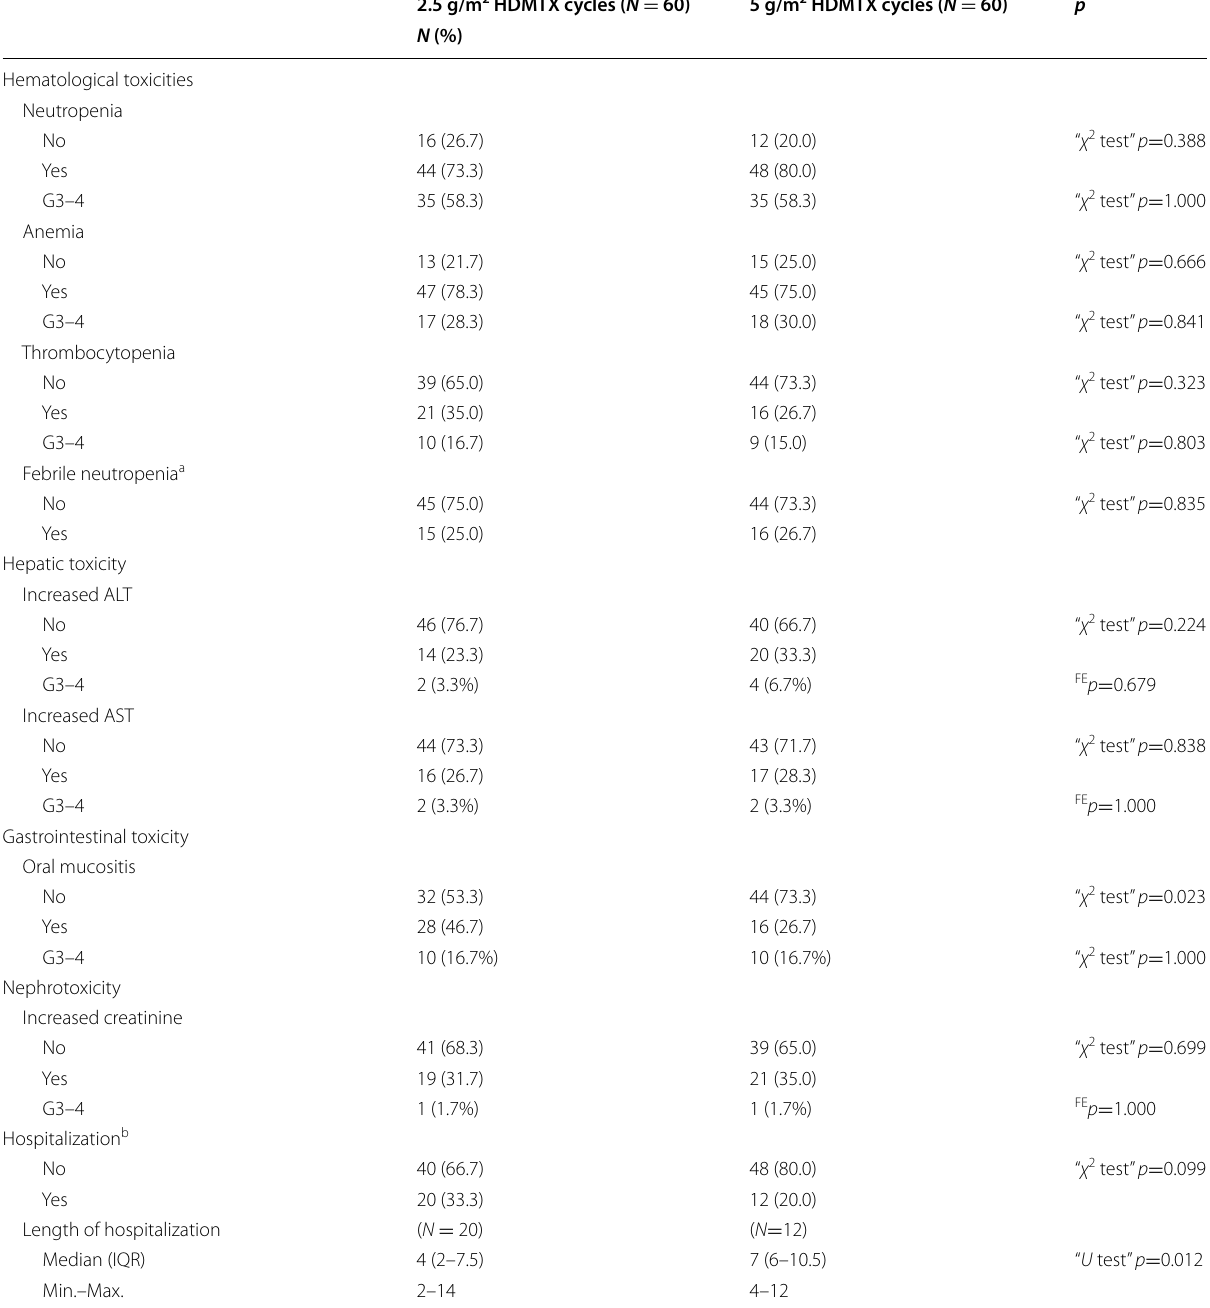
Table 3 Comparison of commonly observed toxicities between 2.5 g/m 2 HDMTX cycles and 5 g/m 2 HDMTX cycles ( N